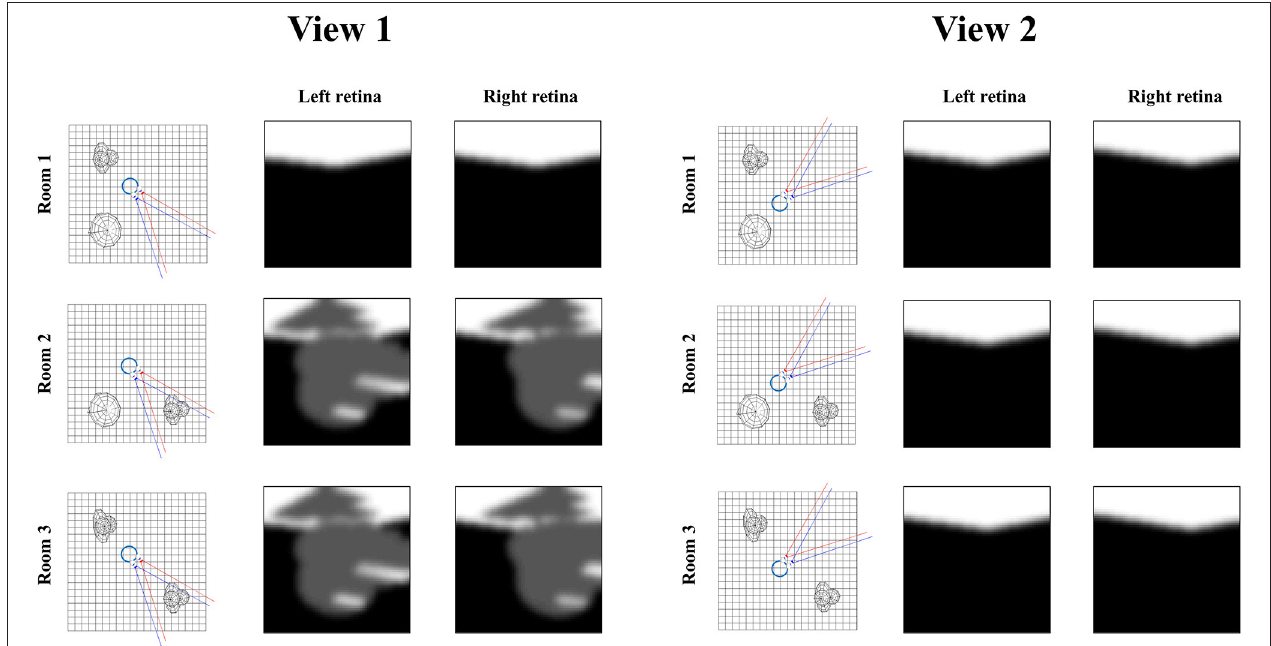
FIGURE 7 | Expected information gain. This figure highlights the role of predictive entropies in adjudicating between salient actions. This shows two alternative fields of view we could choose between, through making eye or head movements. If we were not sure which room we were in, view 1 (toward the southeast corner) would be associated with a high predictive entropy, and is consequently useful in resolving uncertainty. In contrast, view 2 (toward the northeast corner) has zero predictive entropy, and does not help distinguish between